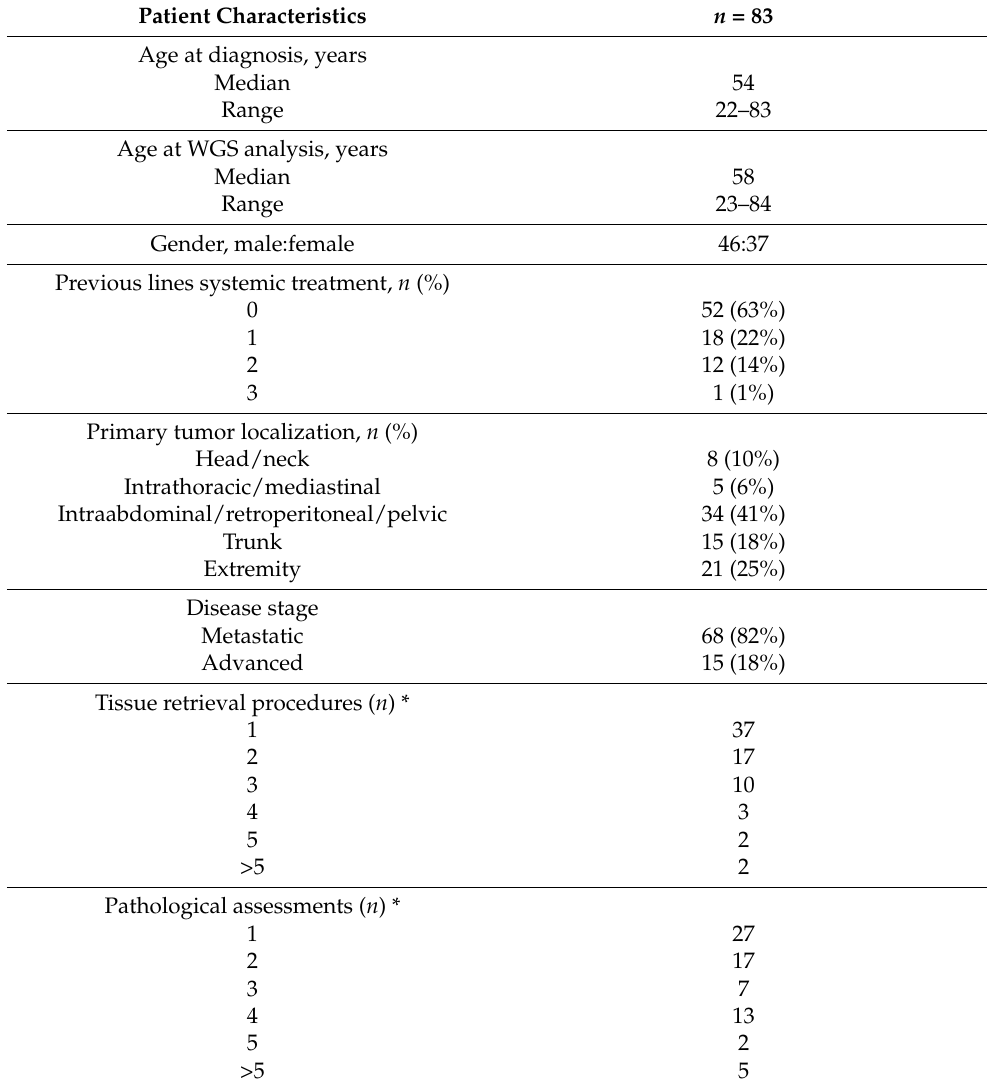
Table 1. Patient